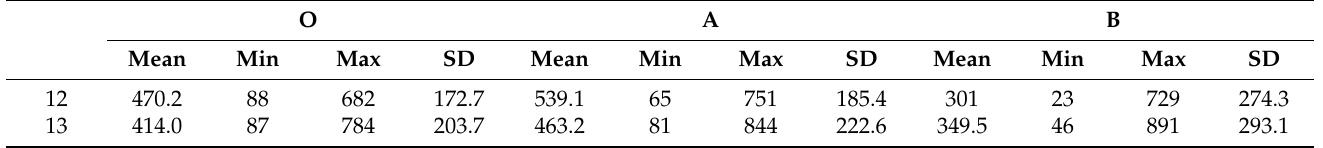
Table 8. Descriptive statistics of solar radiation at each test point on the 12th and 13th (W/m 2 ).